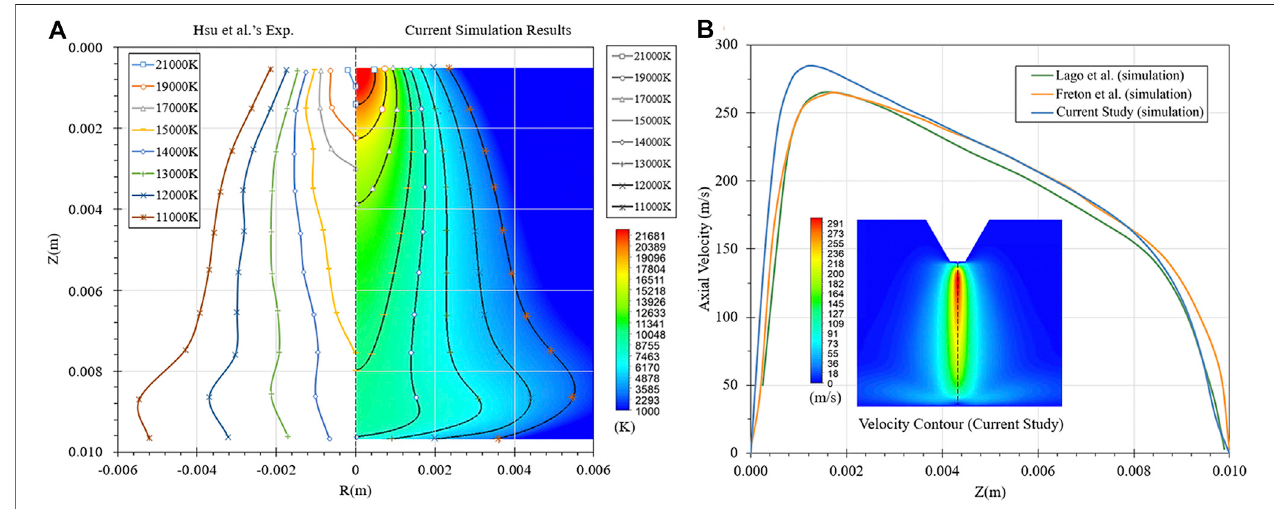
FIGURE 3 | Validation of the DC electric arc plasma. (A) Comparison of simulated isotherms and measurement data. (B) Comparison of velocity distribution at the domain centerline.